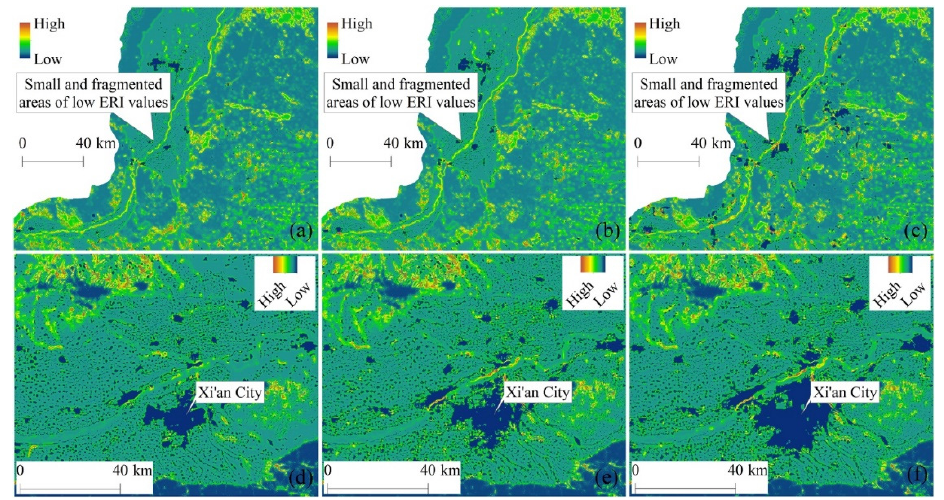
Figure 6. Small and fragmented areas of low LERI values in ( a ) 2000, ( b ) 2010, and ( c ) 2020. Low LERI values in urban areas in ( d ) 2000, ( e ) 2010, and ( f ) 2020.